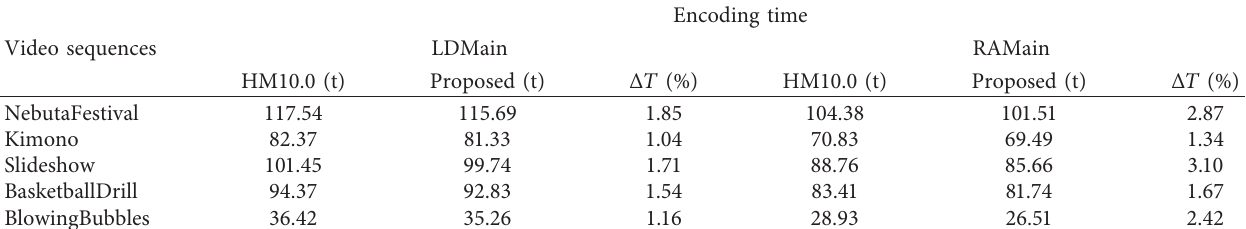
Table 1: The comparison of coding time under two configuration files of LDMmain and